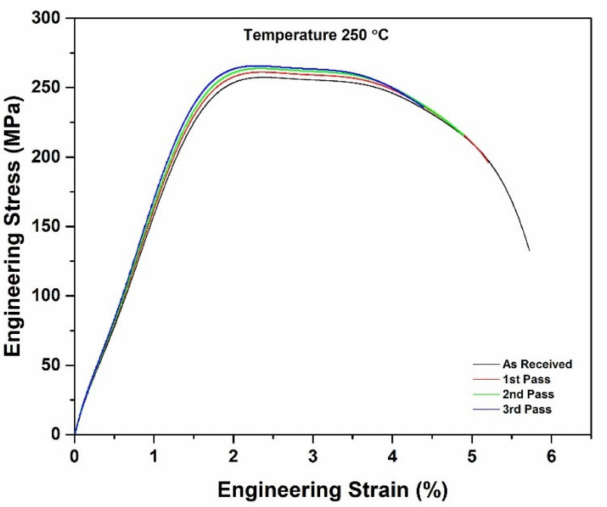
Figure 7. The tensile curve of Al 5083 alloy in 10 − 3 /s strain rates in 250 ◦ C